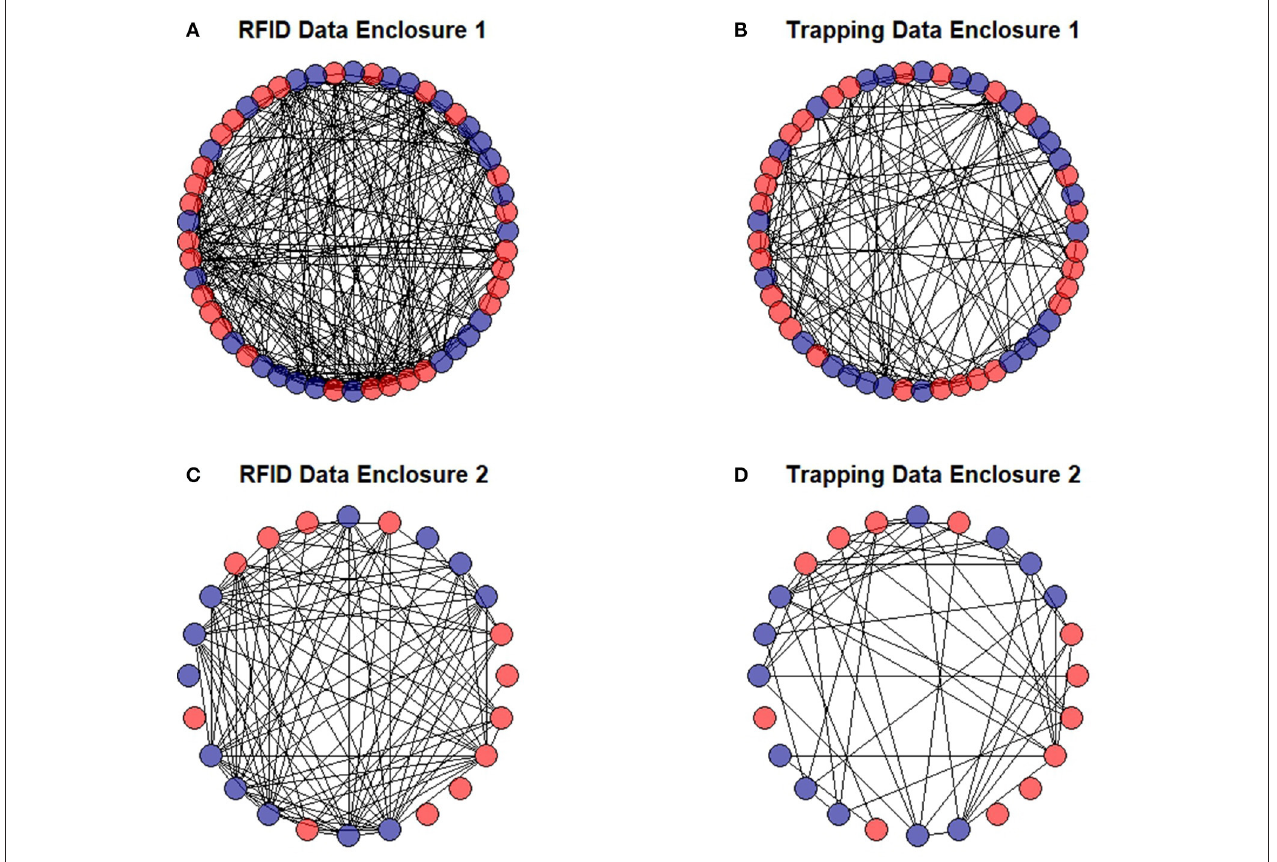
FIGURE 7 | Social networks of prairie voles in two separate enclosures generated by our RFID system (A,C) and multiple capture live-trapping (B,D) . Males are shown in blue and females are shown in red. Individuals with no connections to other individuals likely died soon after they were released into the enclosures.